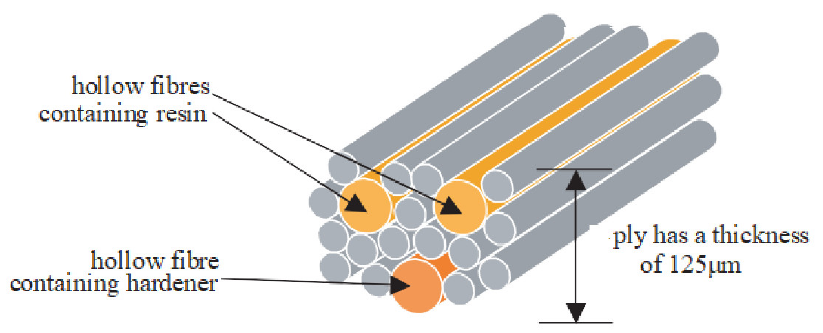
Figure 12. An arrangement of self-healing HGFs with resin and hardener placed within a layer of glass fibers in a stack sequence of a composite laminate. Fiberglass is shown in grey. Reproduced from [32] with permission from the Royal Society.